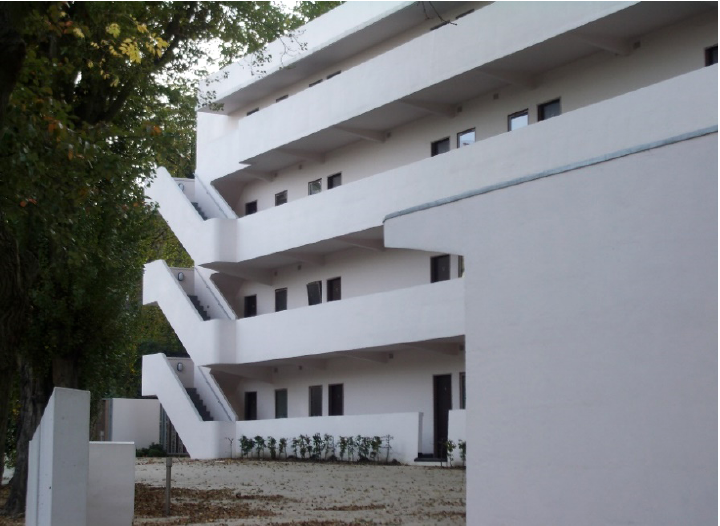
Figure 4. Wells Coates, Isokon Flats, Lawn Road, Hampstead, London, 1934. An application of the Existenzminimum idea in a lowrise collective housing block by a member of the MARS Group, with shared services. It housed Walter Gropius, Arthur Korn, and some other CIAM members in England in the mid-1930s. Source: Wikimedia Commons (2005).